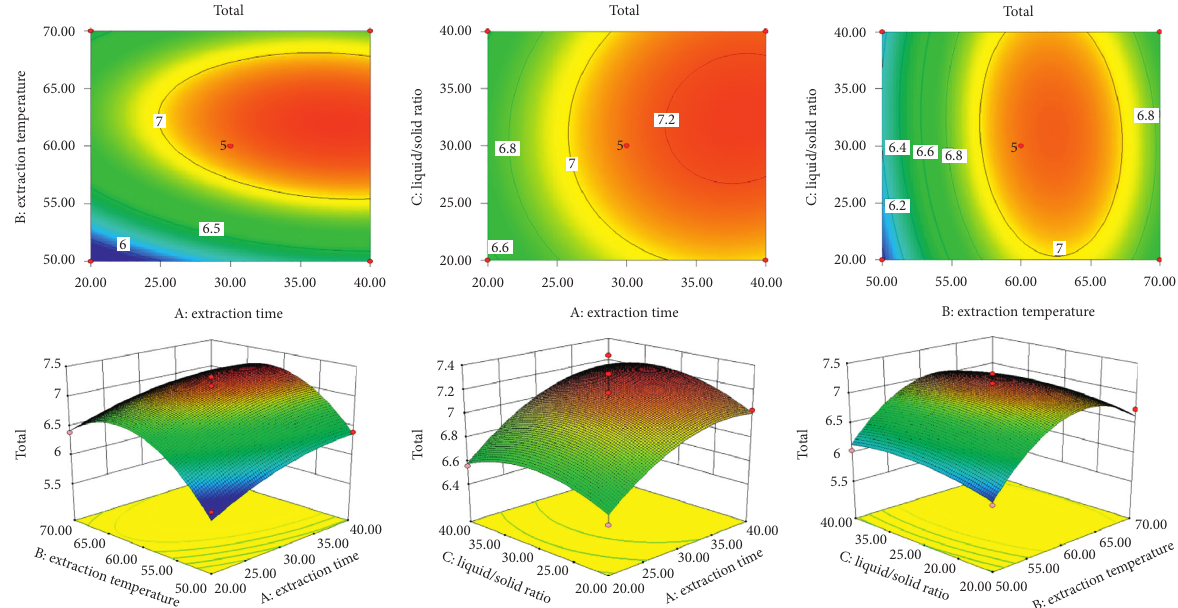
Figure 4: Response surface drawings of total chromones analyzed by interaction of two factors.